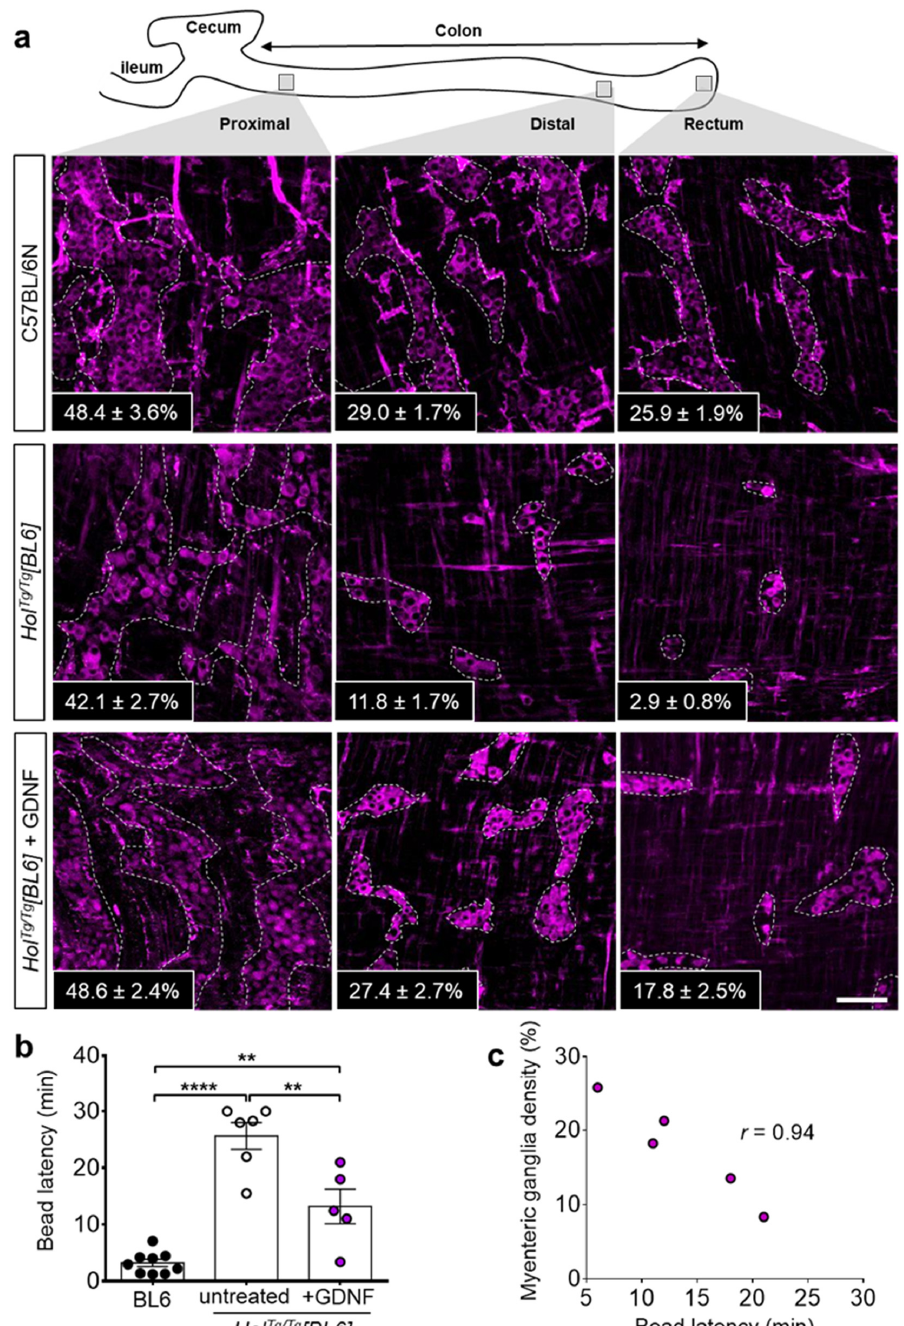
Figure 5. GDNF-induced neurogenesis in the colon of Hol Tg/Tg [BL6] pups. ( a ) Immunofluorescence staining of HuC/D+ neurons in the myenteric plexus of P20 C57BL/6 controls and Hol Tg/Tg [BL6] mutants treated or not with GDNF between P4–P8. Insets refer to the average percentage of surface area occupied by HuC/D+ myenteric ganglia in 3–4 fields of view per corresponding region ( n = 3–5 mice per group, as detailed in Figure S1). Scale bar, 100 µm. ( b ) In vivo analysis of colonic motility in P20 mice using the bead latency test. Time to expel the glass bead after rectal insertion was capped at 30 min to simplify the analysis without impacting statistical significance. ** p < 0.01, **** p < 0.0001, two-way ANOVA with post-hoc Sidak’s test. ( c ) Correlation between myenteric ganglia density and time to expel the bead for P20 Hol Tg/Tg [BL6] mice treated with GDNF between P4–P8.